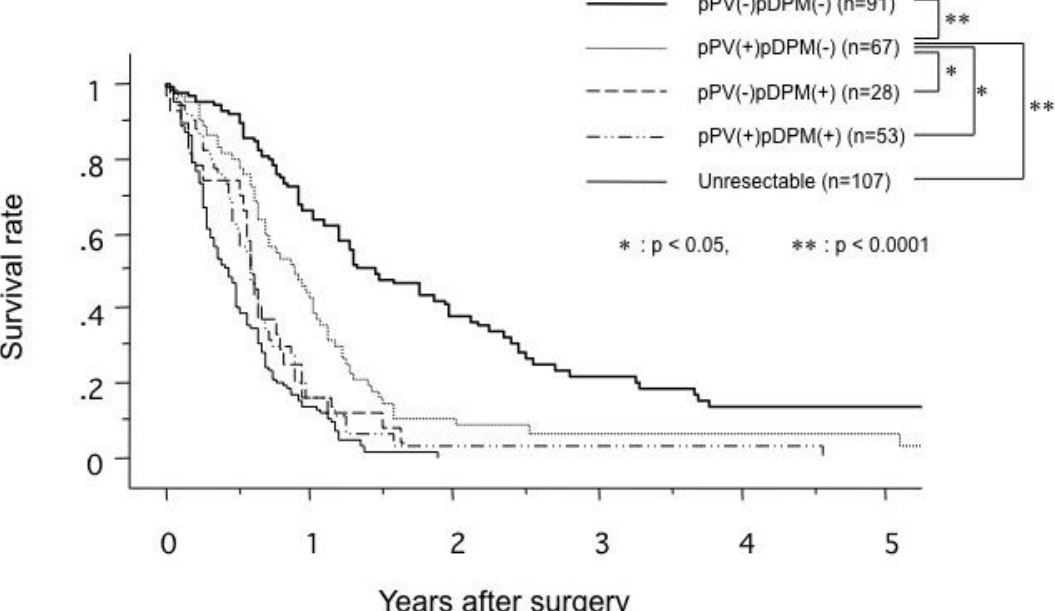
Figure 9. Comparison of cumulative survival rates in patients with and without histological invasion of a venous wall in the portal system (pPV) and invasion of the dissected peripancreatic tissue margin (pDPM) in patients with carcinoma of the pancreatic head (from